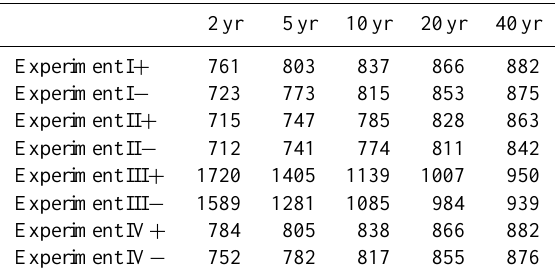
Table 2. Calculated conversion factor f 1V (in kgm − 3 ) for all ex- periments (Fig. 3) and different lengths of the observation period (in years) after a change in mass balance. Scenarios with a positive ( + ) and a negative ( − ) shift in ELA are shown. 2yr